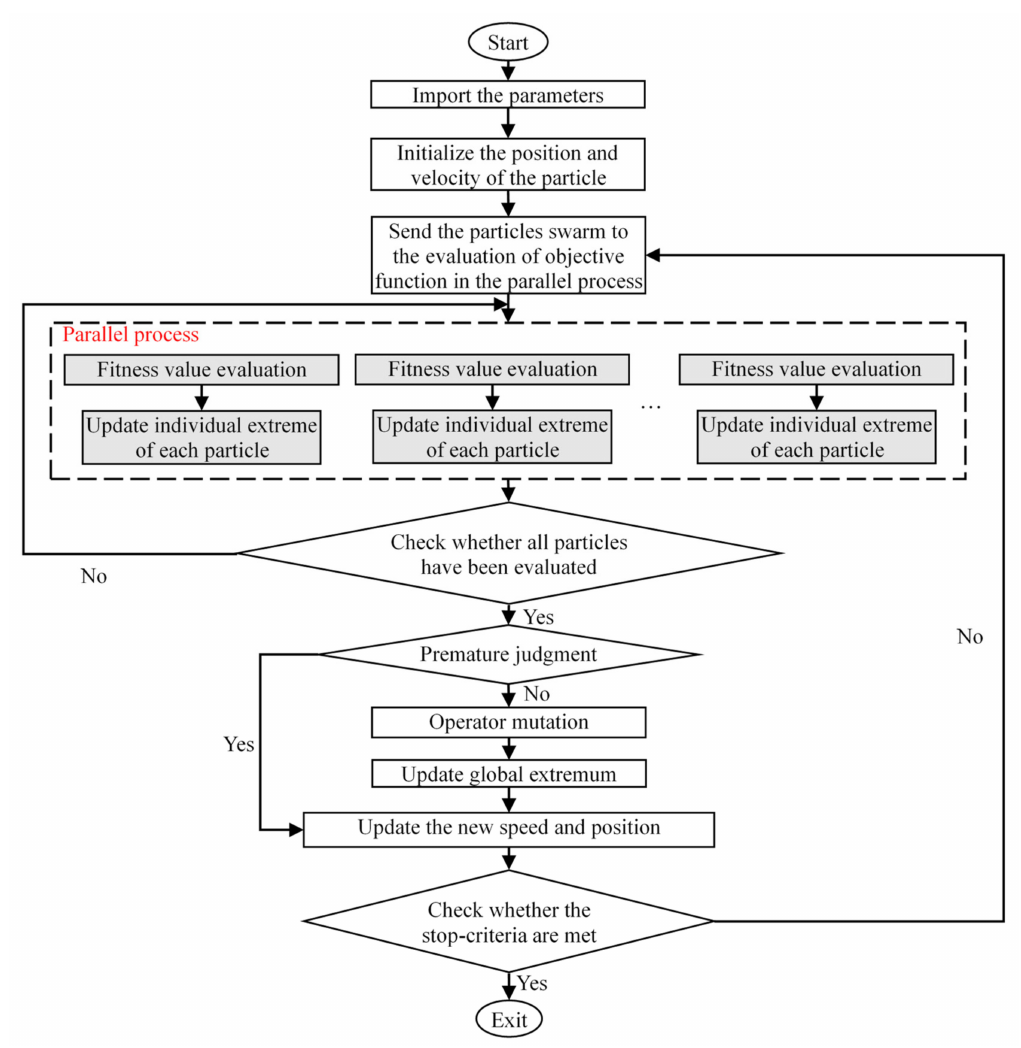
Figure 5. Flow chart of the proposed